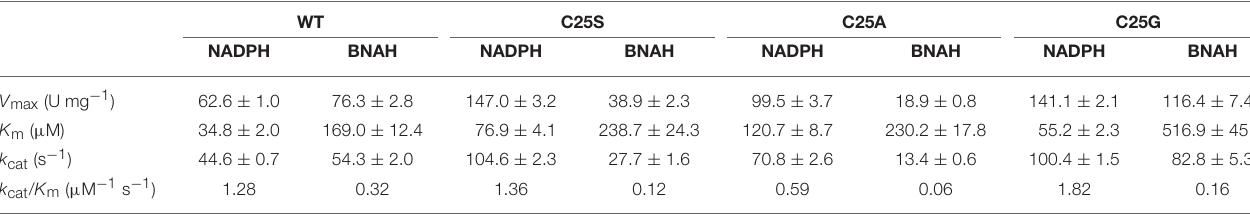
TABLE 2 | Steady-state kinetic parameters of OYERo2a (WT) and Cys variants regarding cofactor preference. WT C25S C25A C25G NADPH BNAH NADPH BNAH NADPH BNAH NADPH